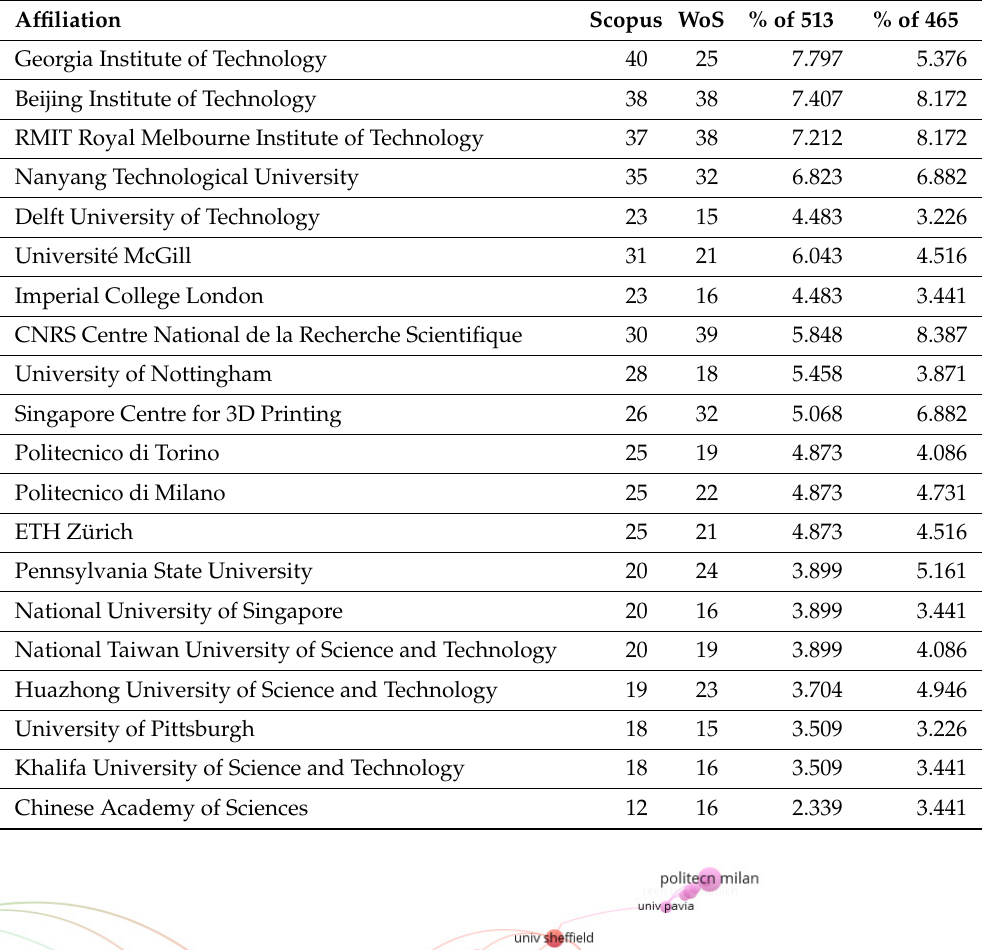
Table 3. Comparisons on publication affiliation for “additive manufacturing on lattice structure” research (data retrieved from Scopus and WoS on 20 June 2022).